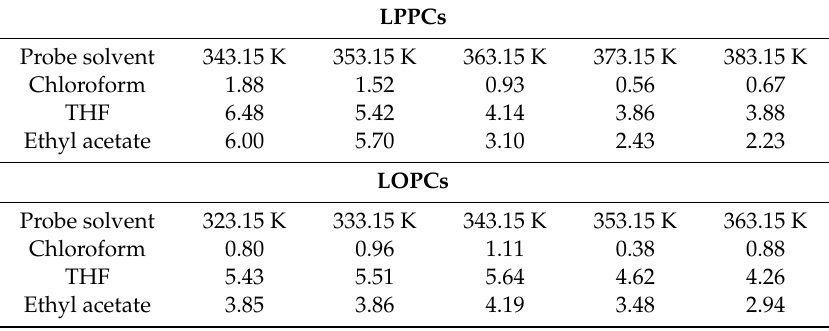
Table A9. Surface specific adsorption free energy ∆ G sp (kJ / mol) of LPPCs and LOPCs at di ff erent